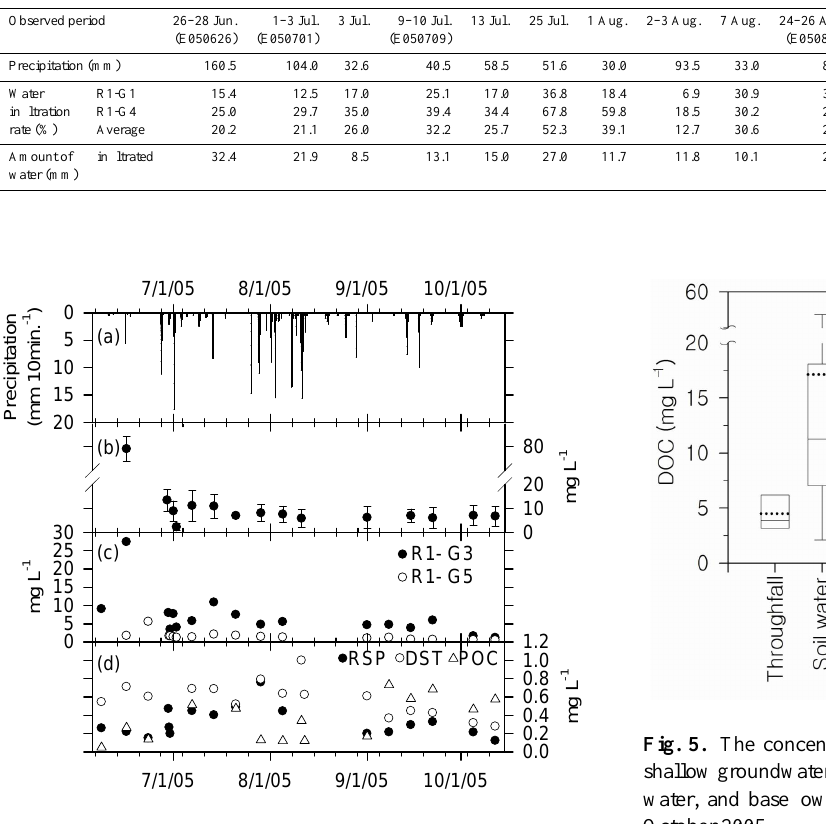
Fig. 4. Variations in (a) precipitation and DOC concentrations in (b) soil water, (c) groundwater, and (d) spring water (RSP), streamwater (DST), and POC concentration (POC) in streamwater during the periods of baseflow conditions from June to October 2005. Vertical error bar in (b) soil water means standard deviation.